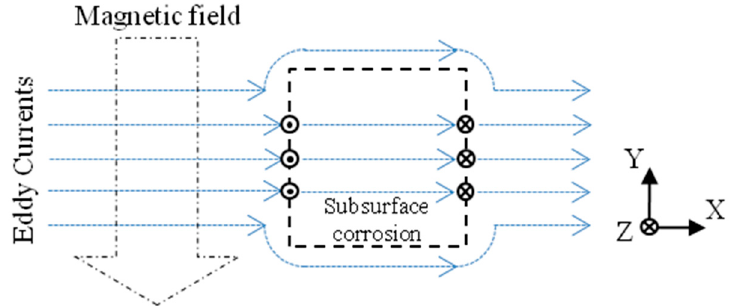
Figure 1. Schematic illustration regarding the interaction of the uniform eddy current with subsurface corrosion (top view). corrosion (top